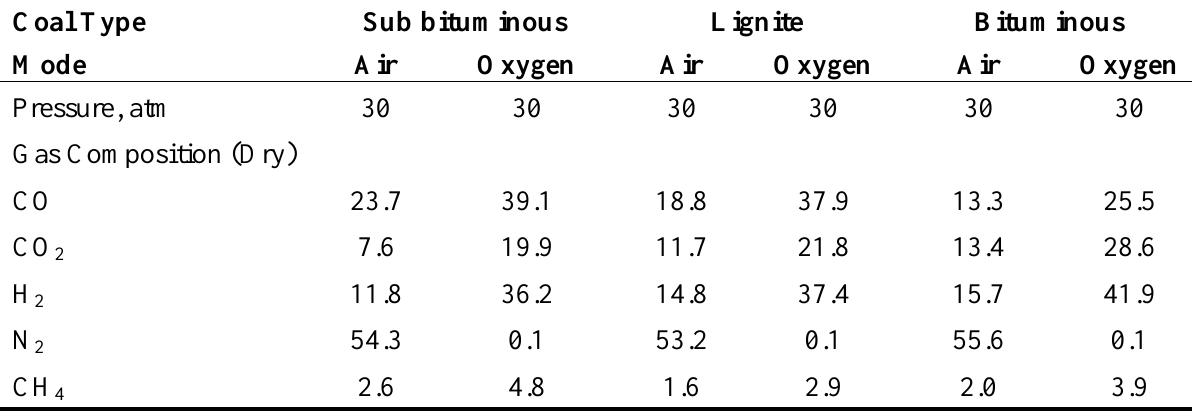
Table 9. Typical gas analysis from the Transport Gasifier Pilot Plant